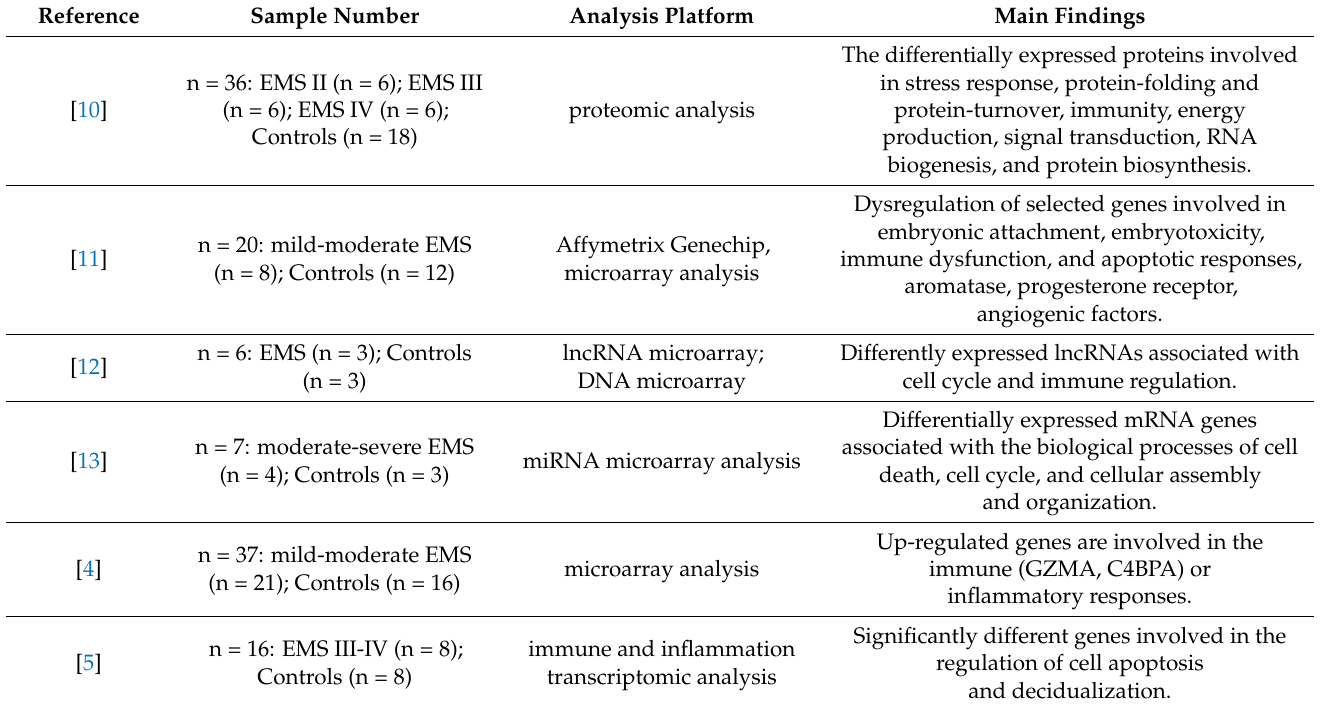
Table 1. Gene profile and protein expression of secretory endometrium in